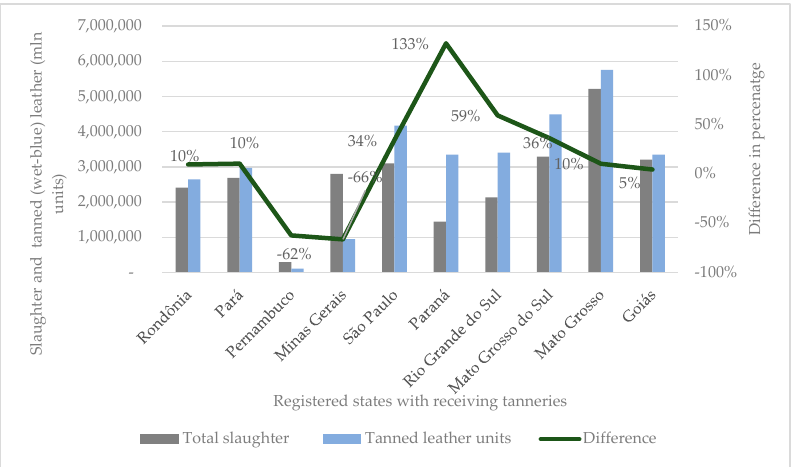
Figure 3. Total slaughter and acquisition of tanned (wet blue) leather by tanneries and their differ- ence per state in 2018. Source: Authors’ own elaboration based on IBGE data [113].